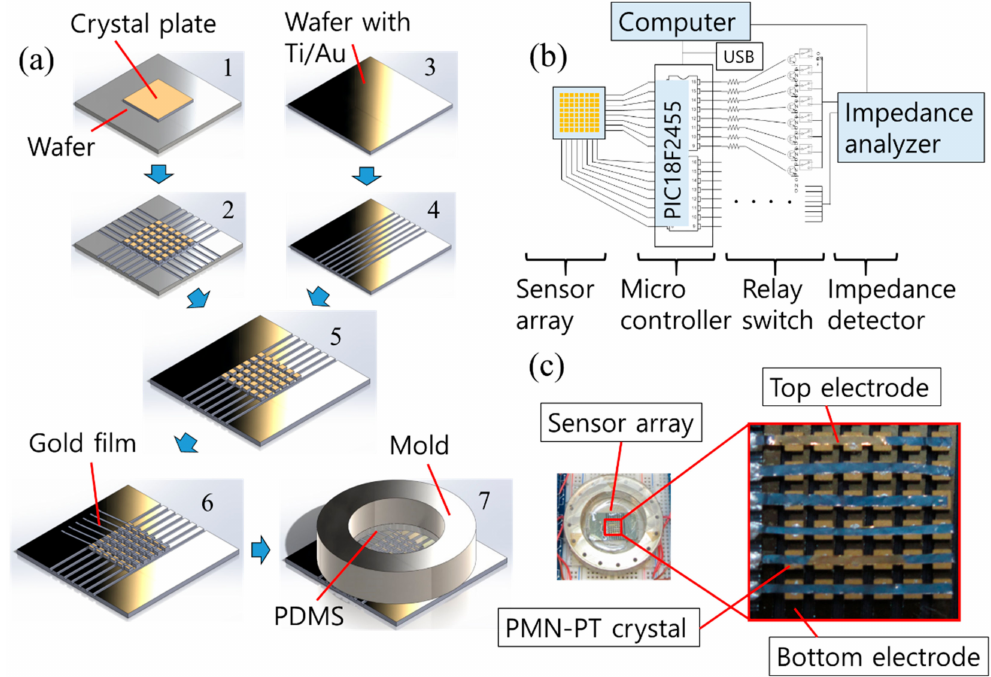
Figure 2. ( a ) 6 × 6 array fabrication process; ( b ) the block diagram of the array impedance measurement system and the switch circuit; ( c ) the fabricated 6 × 6 array with the switch and microcontroller